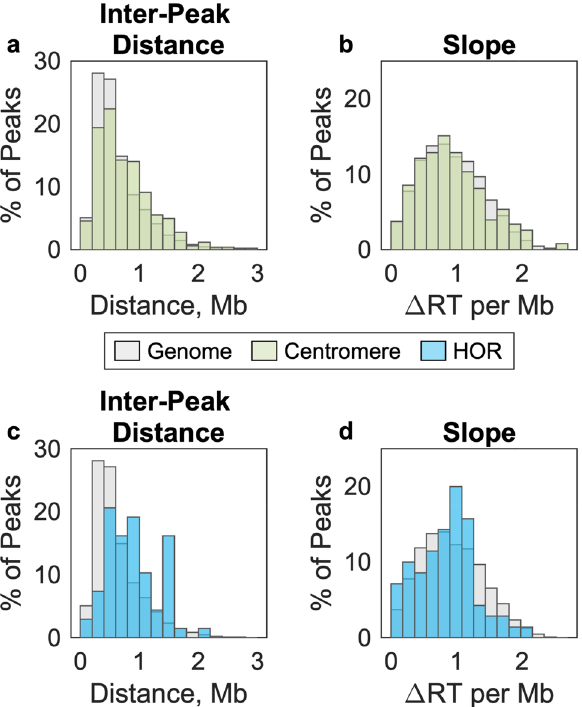
Figure 5. Replication timing (RT) dynamics are not substantially different in centromeric regions than in the rest of the genome. ( a , c ) The distance between RT peaks was used as a metric of inter-origin distance. Inter- origin distances were slightly larger in centromeric regions (green, a ) and α-satellite higher-origin repeats (blue, c ), relative to the rest of the genome (gray). ( b , d ) RT profile slope was used as a proxy for replication fork speed. For each peak, the ascending and descending slopes are averaged. RT slopes were slightly shallower in centromeric regions (green, b ) and α-satellite higher-origin repeats (blue, d ), relative to the rest of the genome (gray). RT values are for the lymphoblastoid cell line